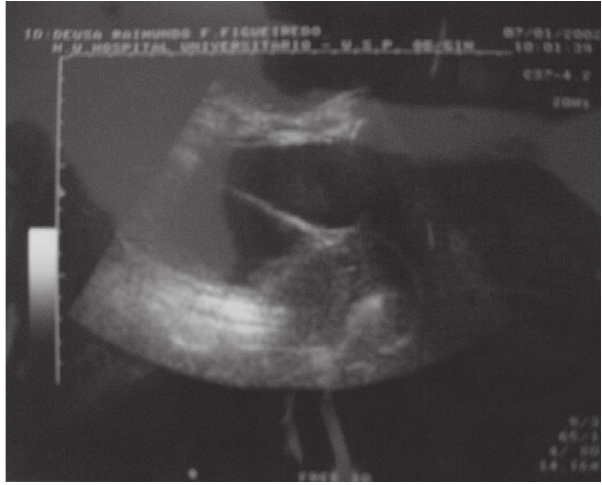
Figure 1 - Achado ultrassonográfico de faixa de propilene na luz vesical